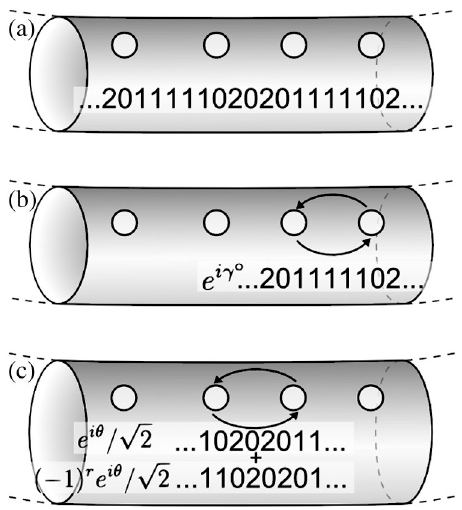
FIG. 8. Graphical representation of the result of exchanging two Pfaffian quasiholes for two representative pairs. (a) A possible state in which four quasiholes could be prepared, labeled by its associated thin torus pattern. The state shown could be a four- quasihole state, in which the 20 strings at either end would continue around the torus, or could be a 2 n -quasihole state for n > 2 , in which the ellipses mask additional domain walls in the thin torus pattern. The results of braiding any pair of quasiholes will be the same in either case. In the following, we show only the sectionofthepatternrelevanttotheexchange;localityimpliesthat only the segment of the pattern within a magnetic length of the exchange path may be affected by the exchange and the rest remains fixed. (b) Upon exchange of the indicated quasiholes, the state picks up the phase (cid:12) o , given by Eq. (98b). Had the 11 string separating the quasiholes been even in length, the phase would havebeen (cid:12) e , Eq.(98c). In either case the thintorus pattern, and thus the topological sector of the state, remains unchanged, which is shown. (c) When the two indicated quasiholes are exchanged the state remains in the same topological sector or transitions into a sector with the linking 20 strings shifted. The amplitudes for these two possibilities are shown next to the thin torus patterns for the sectors, where (cid:16) ¼ (cid:2) ½ 1 = 8 þ r= 4 þð(cid:1) 1 Þ r = 4 (cid:7) . r is an integer labeling the eight possible values for the overall Abelian phase, where r ¼ 0 reproduces the representation given by conformal block